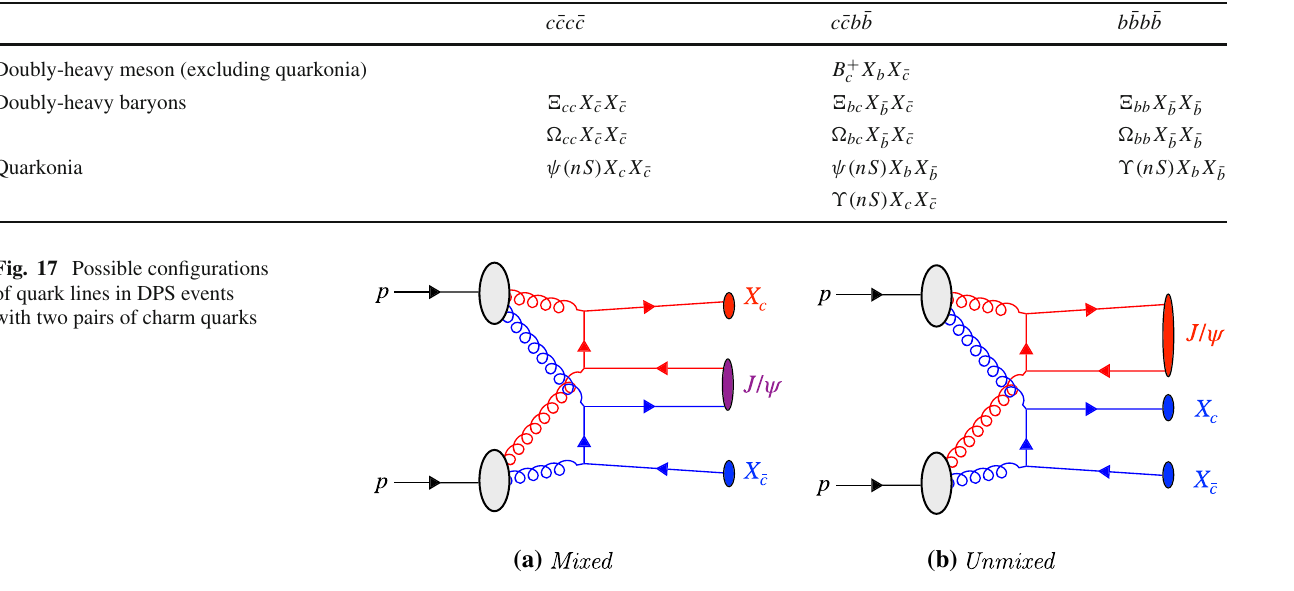
Table 5 Examples of combinations of doubly- and singly-heavy hadrons in processes with two pairs of heavy quarks